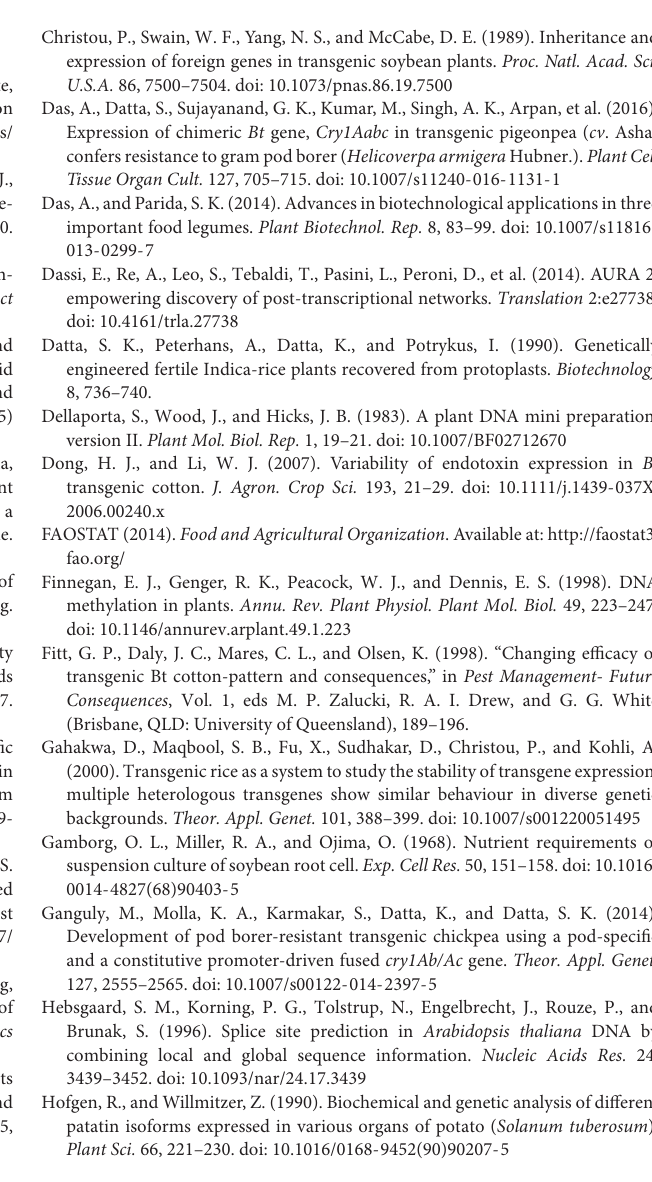
FIGURE S1 | T-DNA of pBinAR containing cry1Aabc gene (RB, right border; P nos , nopaline synthase promoter; nptII , neomycin phospho transferase II; T nos , nopaline synthase terminator; T ocs , octopine synthase terminator; cry1Aabc , domain shuffled Bt gene; P35S, Cauliflower Mosaic Virus 35S promoter; LB, left border). FIGURE S2 | Agrobacterium mediated genetic transformation of chickpea. (A) Germinated seedlings of chickpea; (B) decapitated shoots and roots; (C) axillary meristem explant (AME); (D) induction of multiple shoots after co-cultivation; (E) elongation of multiple shoots; (F) separation of elongated shoots; (G) grafting; (H) hardening of grafts; (I) acclimatized plants; and (J) mature fertile